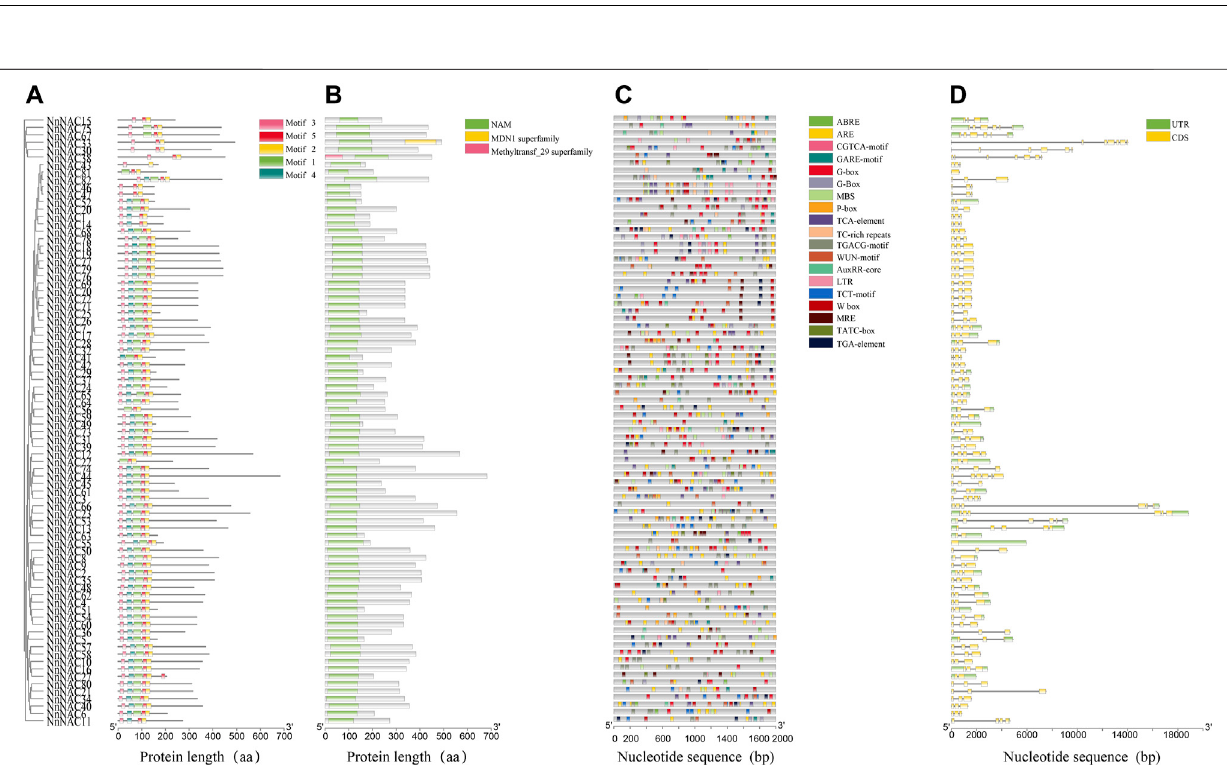
Frontiers in Genetics |